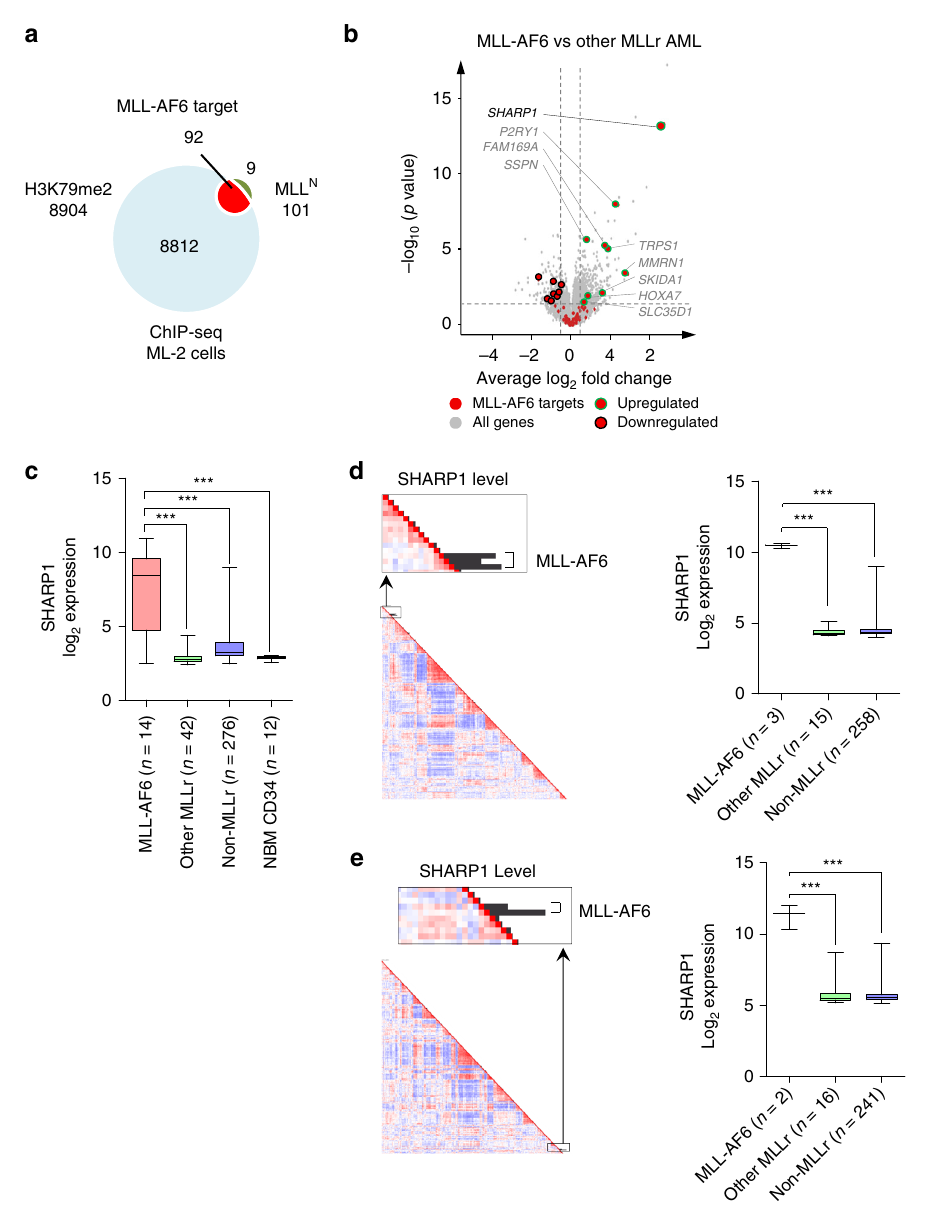
Fig. 1 Overexpression of SHARP1 in MLL-AF6 AML patients. a Venn diagram showing MLL-bound (101 genes) and H3K79me2 enriched genes (8904 genes) obtained from ChIP-seq analysis of ML-2 cells for identi fi cation of 92 MLL-AF6 target genes. b Volcano plot showing average log 2 fold change against − log 10 p value for all genes in MLL-AF6 AML ( n = 14) vs all the other subtypes of MLL -rearranged AMLs (other MLLr) ( n = 42). Gene expression data of patients were obtained from GSE19577, GSE14468 and GSE61804. Red dots MLL-AF6 target (92 genes), Green circles upregulated targets (9 genes), Black circles downregulated targets (8 genes). c Box plot showing SHARP1 log 2 expression in AML patients and normal bone marrow (NBM) CD34 + cells. SHARP1 log 2 expression level: MLL-AF6 7.504 ± 0.788 ( n = 14), Other MLL 2.854 ± 0.065 ( n = 42), Non-MLL 3.623 ± 0.064 ( n = 276), NBM CD34 2.856 ± 0.036 ( n = 12). Gene expression data of NBM CD34 + cells were from GSE19429. d , e Left panel: Unsupervised hierarchical gene- expression clustering from 2 distinct cohorts of adult AML patients from GSE1159 ( d n = 285) and GSE6891 ( e n = 268). The bars indicate SHARP1 gene expression. All of the fi ve high SHARP1 cases have the MLL-AF6 fusion gene. Right panel: Box plot showing SHARP1 log 2 expression in AML patients. SHARP1 log 2 expression level: d MLL-AF6:10.45 ± 0.096 ( n = 3), Other MLL 4.383 ± 0.082 ( n = 15), Non-MLL 4.566 ± 0.045 ( n = 258). The cytogenetics was not determined in 9 cases. e MLL-AF6 11.18 ± 0.828 ( n = 2), Other MLL 5.916 ± 0.257 ( n = 16), Non-MLL 5.658 ± 0.033 ( n = 241). The cytogenetics was not determined in 9 cases. All box plots extend from the 25 th to 75 th percentiles and the whisker extends from the minimum level to the maximum. Median value is plotted in the box. *** p <